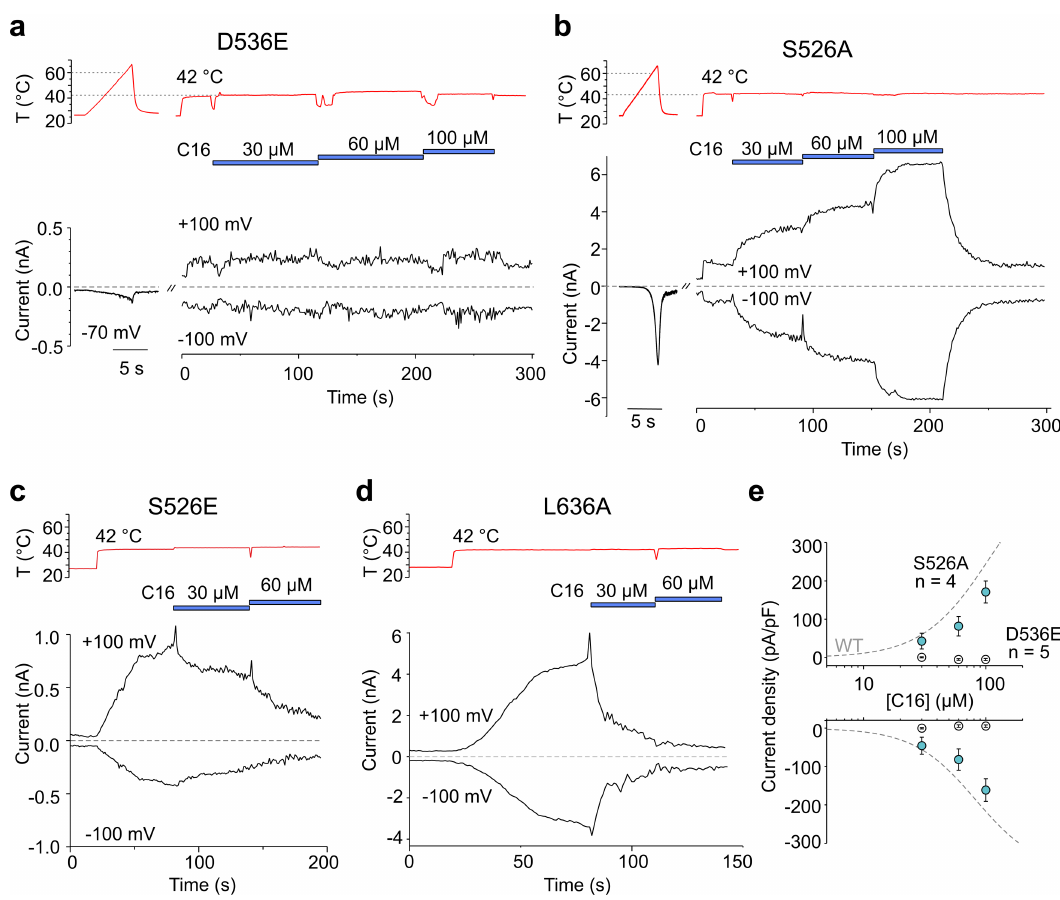
Fig. 6 | Functional validation of the C16 binding site. Representative whole-cell currents of D536, S526 and L636 rat TRPV2 mutants expressed in HEK293T cells elicited by heat applied in control extracellular solution and then by C16 applied sequentially at concentrations of 30, 60 and 100 µ M (marked by horizontal blue bars) at 42°C. a C16 did not evoke outward and inward currents in the D536E mutant. b The mutant S526A retains the sensitivity to C16. c , d As shown by